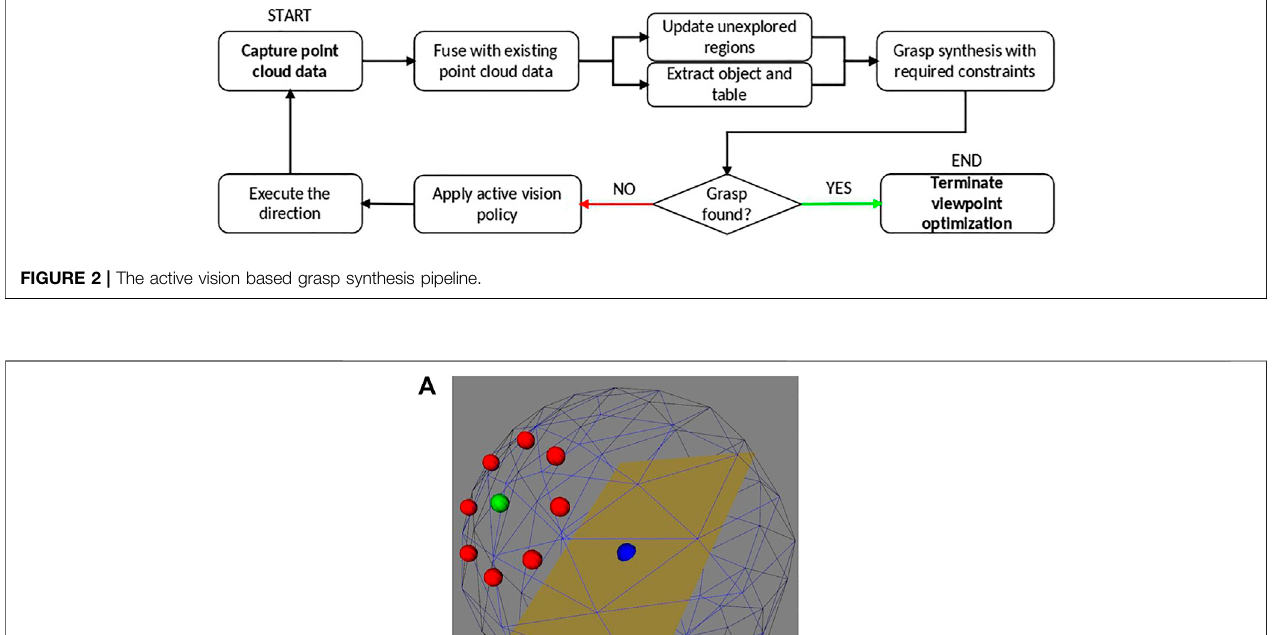
Frontiers in Robotics and AI |